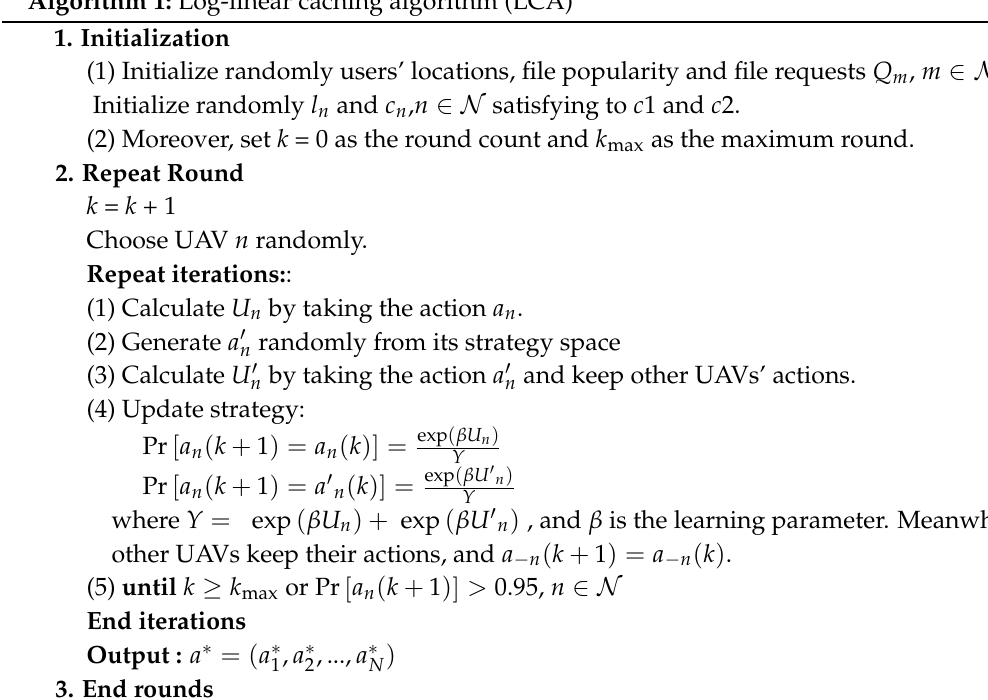
Algorithm 1: Log-linear caching algorithm